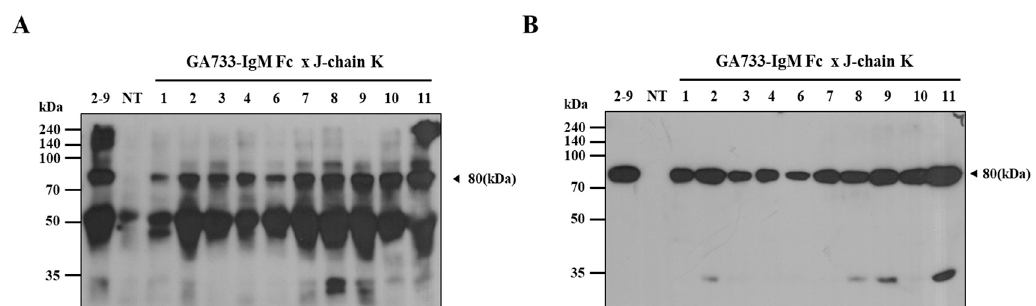
Figure 8. Immunoblot analysis to confirm the expression of EpCAM–IgM Fc in representative F 1 transgenic lines. ( A ) F 1 transgenic plants M209-1–209-10 were tested by goat anti-IgM Fc µ-chain